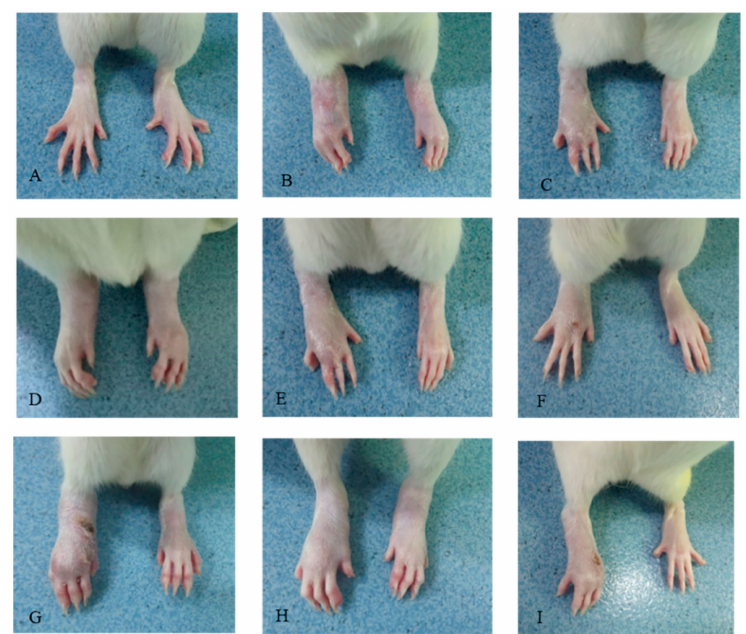
Figure 2. Effects of cardenolide-rich fraction (CDLF) and caffeoylquinic acid-rich fraction (CQAF) on paw edema in CIA rats. ( A ) Non-treated group; ( B ) CIA-treated control group; ( C ) tripterygium glucosides (TGT) treated (37.5 mg/kg); ( D ) CQAF treated (125 mg/kg); ( E ) CQAF treated (250 mg/kg); ( F ) CQAF treated (500 mg/kg); ( G ) CDLF treated (125 mg/kg); ( H ) CDLF treated (250 mg/kg); and ( I ) CDLF treated (500 mg/kg).